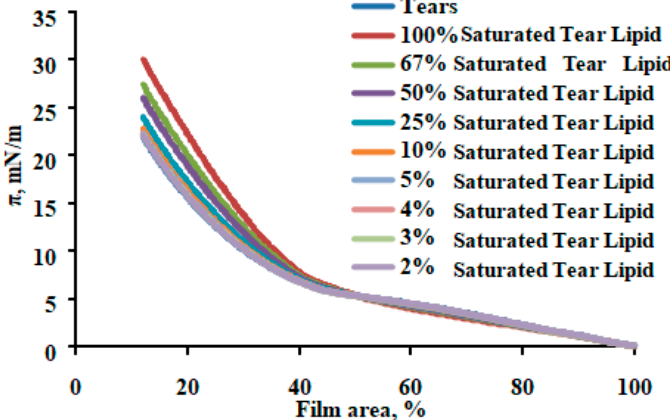
Figure 5. In the case of tears, catalytic saturation enhances maximum surface pressure without alteration of spreading (= the low π part of the isotherms). This reflects two points: (i) the tear film lipid layer (TFLL) is somewhat different from meibum and (ii) TFLL tolerates saturation and its properties are enhanced by it.